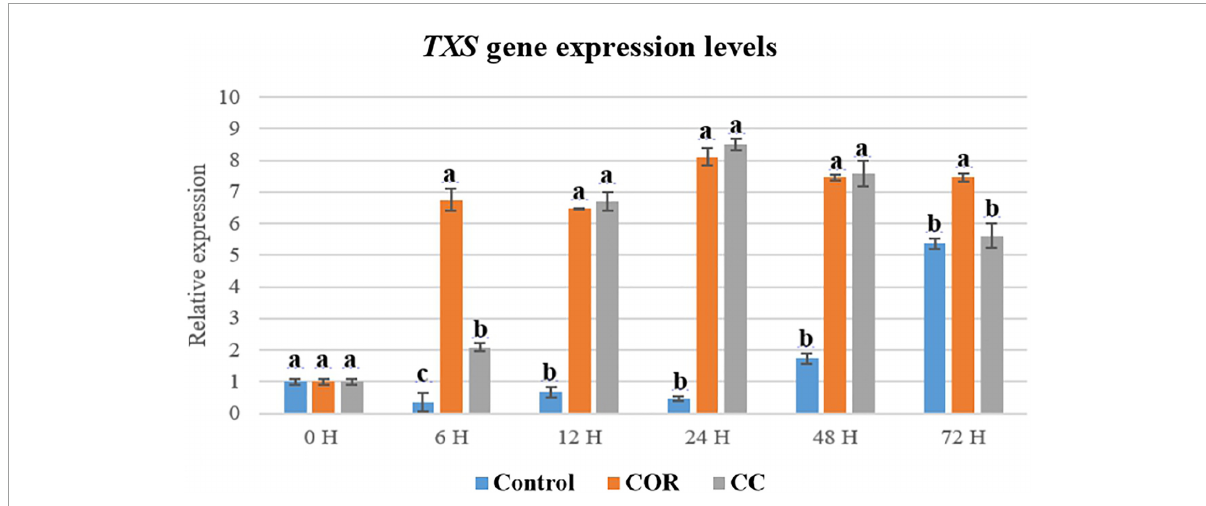
FIGURE9 Relative expression of TXS gene in T. baccata cell cultures grown in Control conditions and elicited with 1 mM coronatine (COR) or 1 mM coronatine + 50 mM methyl- β -cyclodextrins (CC). The relative gene expression levels were normalized with respect to the same cell line growing for 12 days in the growth medium (GM) without elicitors (reference value = 1). Values presented are means ± SD ( n = 3). Values followed by different letters are significantly different ( P ≤ 0.05) according to Tukey’s honestly significant difference test.